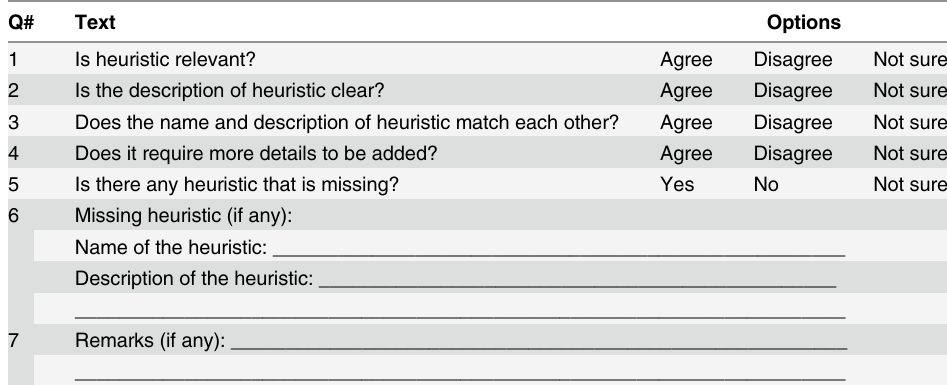
Table 4. Questions and options.